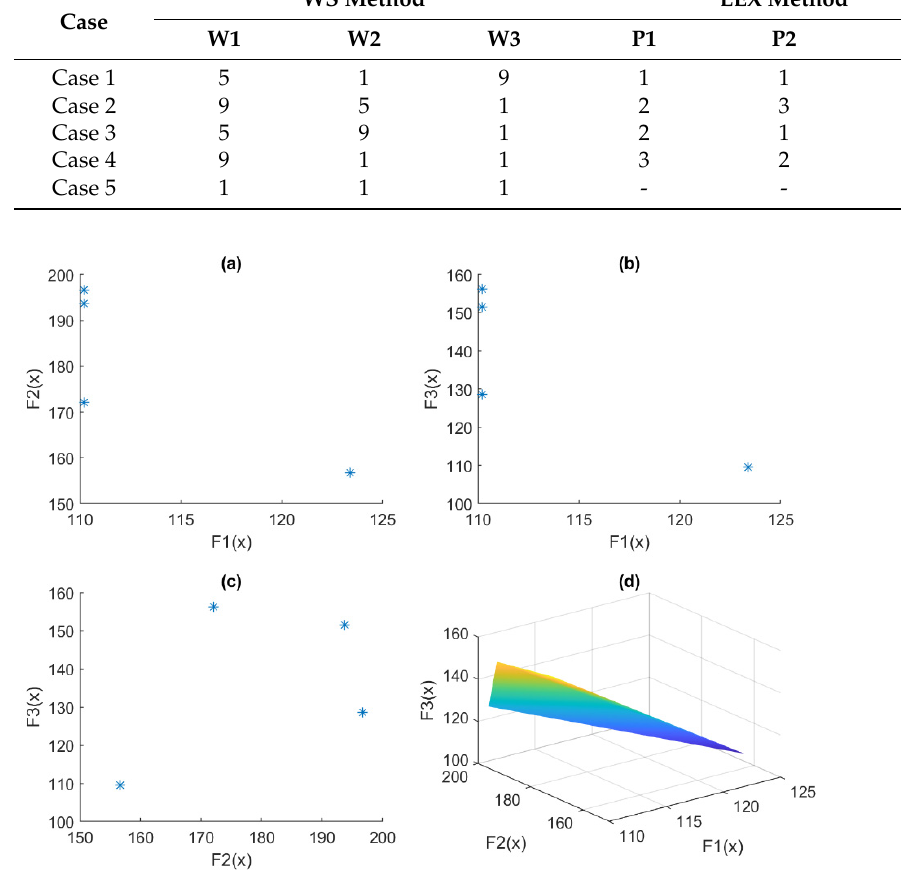
Figure 3. Results of WS method: ( a ) F1 vs. F2; ( b ) F1 vs. F3; ( c ) F2 vs. F3; ( d ) 3D plot. Table 2. Weights used for WS and LEX methods.